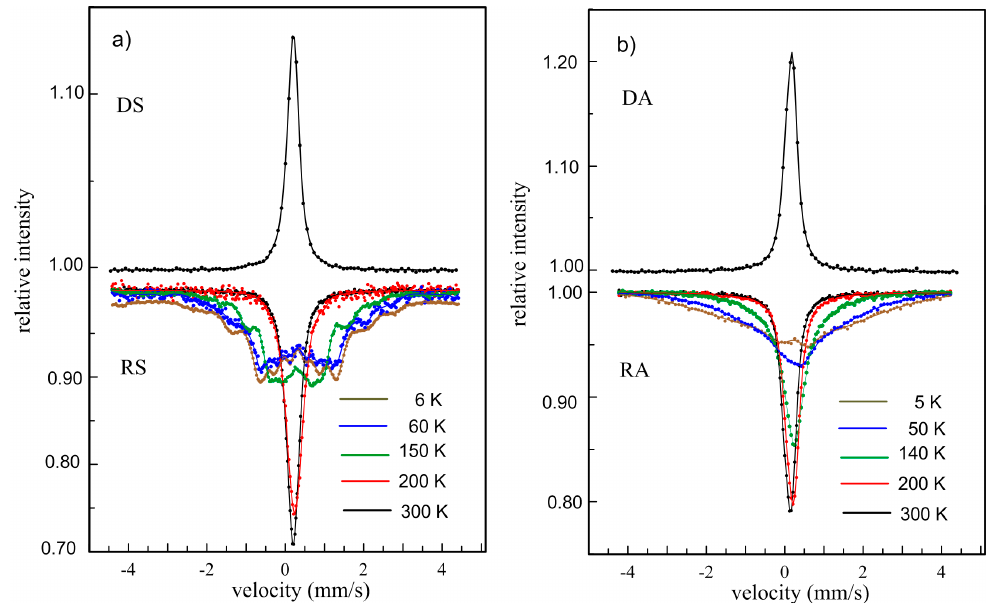
Figure 5. Room-temperature Mössbauer spectra of the Fe 2 MnSi ( a ) and Fe 2 MnAl ( b ) Heusler alloys prepared by arc melting (DS, DA) and planar flow casting (RS, RA) and low-temperature Mössbauer spectra for the RS and RA samples. Table 3. Mean values of the hyperfine induction ( B m ) and fractional intensities ( A ) obtained for Fe 2 MnSi (RS) samples prepared by planar flow casting at low temperatures (see text). The A p corresponds to residual paramagnetic